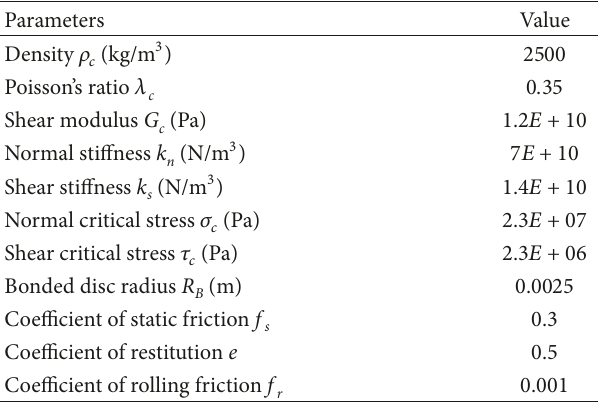
Table 1: Particle bonding parameters for concrete.